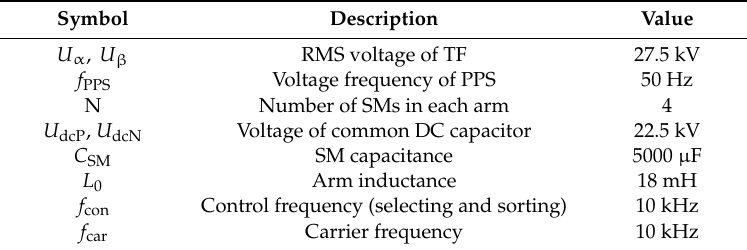
Table 2. Parameters in simulation